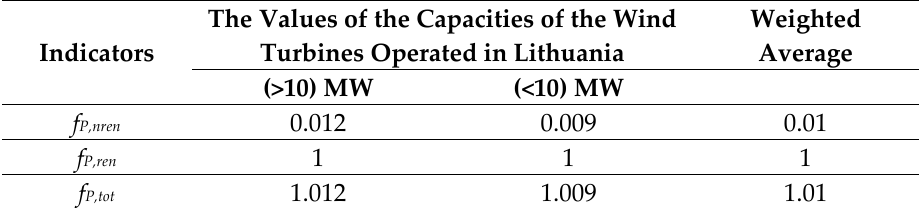
Table 1. The result of the primary energy factor (PEF)